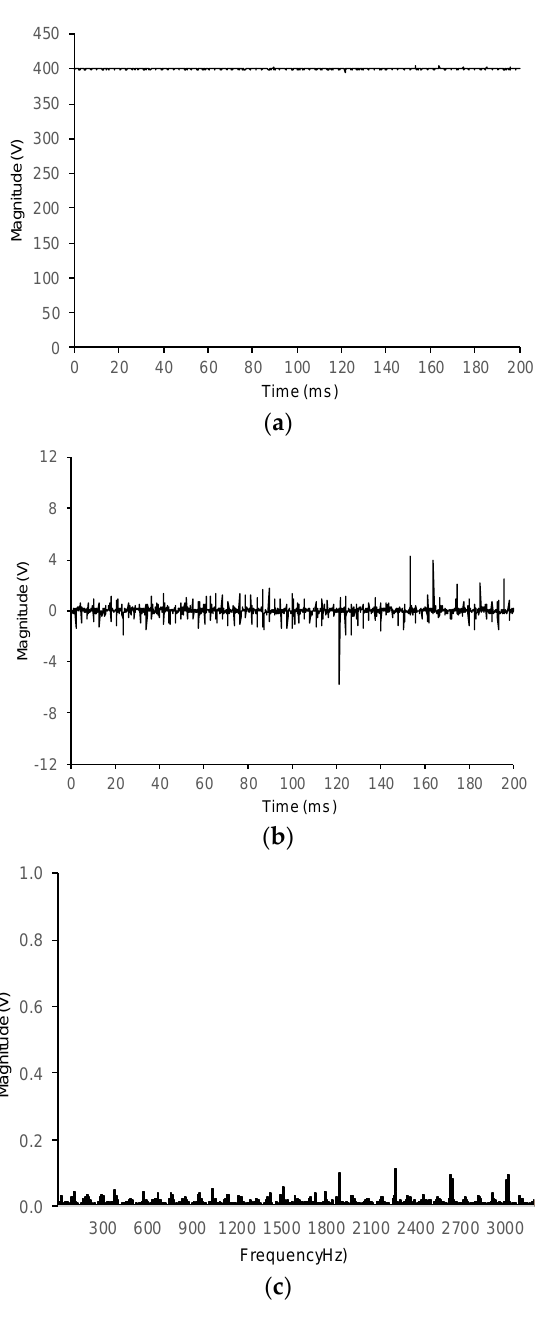
Figure 7. ( a ) DC voltage shape of quasi-ideal programmable DC power source, ( b ) ripple content, and ( c ) spectral components in voltage ripple excluding the DC component.